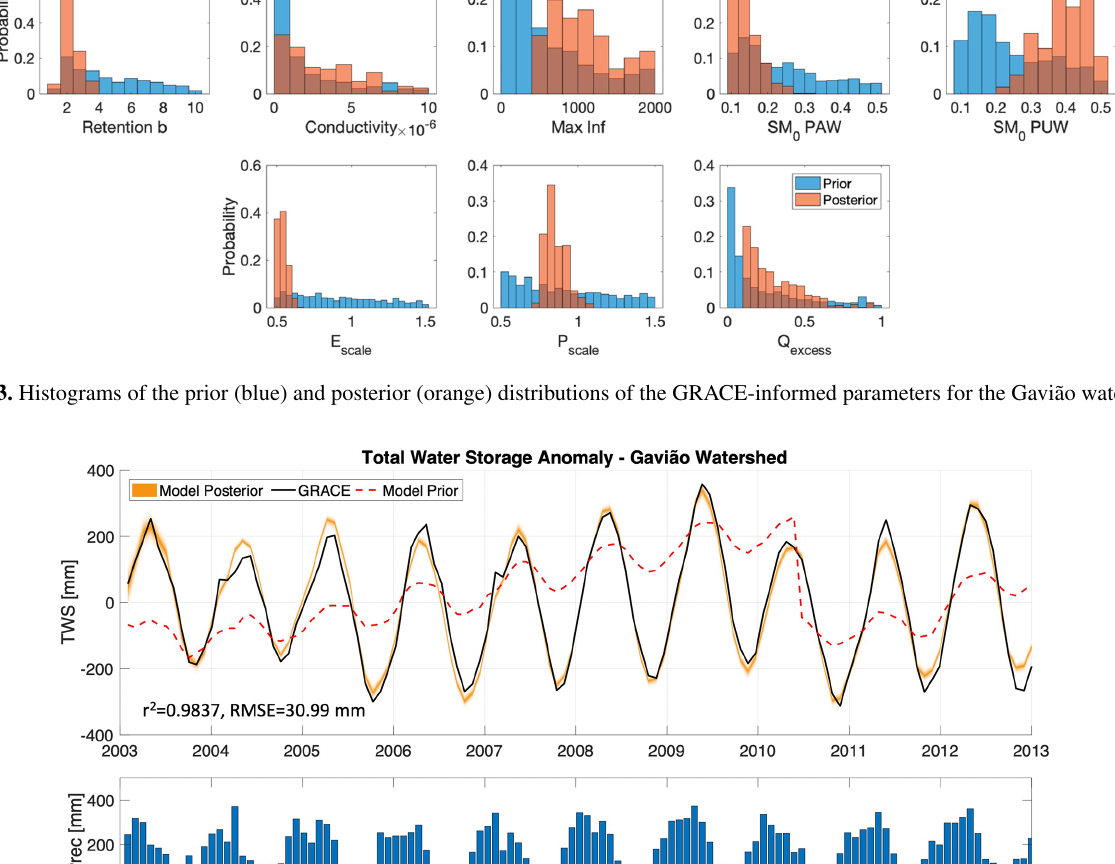
with concurrent GRACE measurements, with an r 2 = 0 .